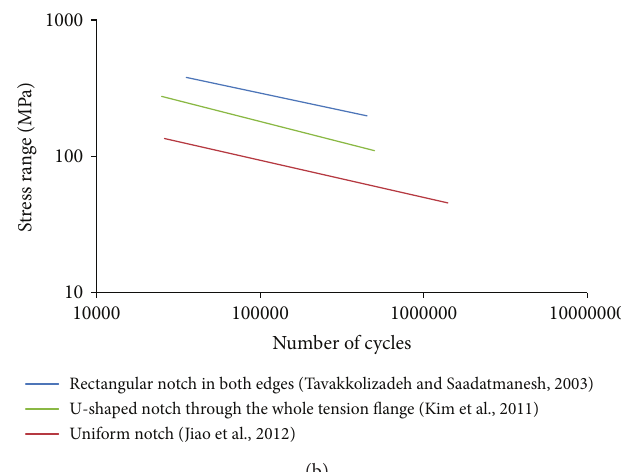
Figure 1: (a) Types of notch in steel beam. (b) Stress behaviour in fatigue for different notch categories [14, 37, 40].